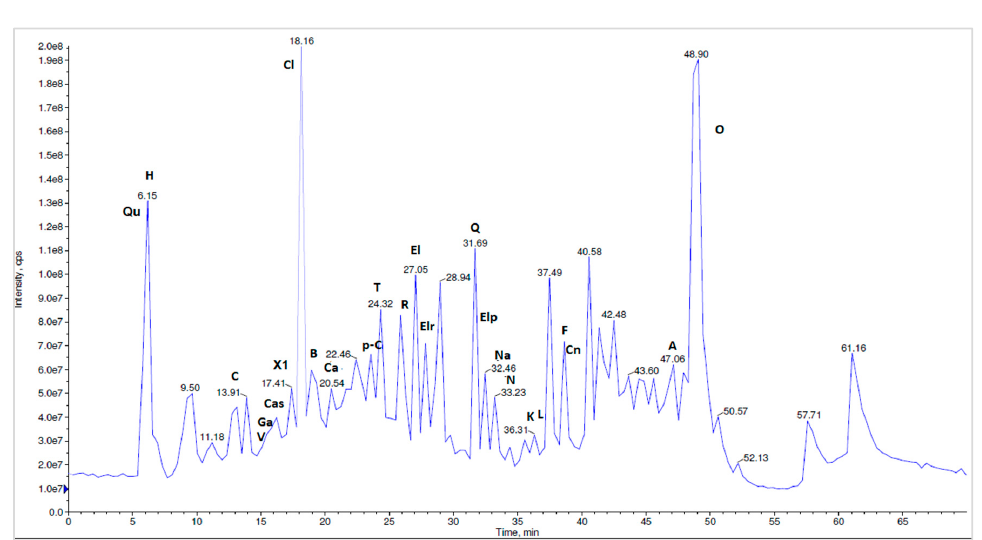
Figure 9. The LC-MS/MS chromatographic separation of the methanolic N. alba flower extract